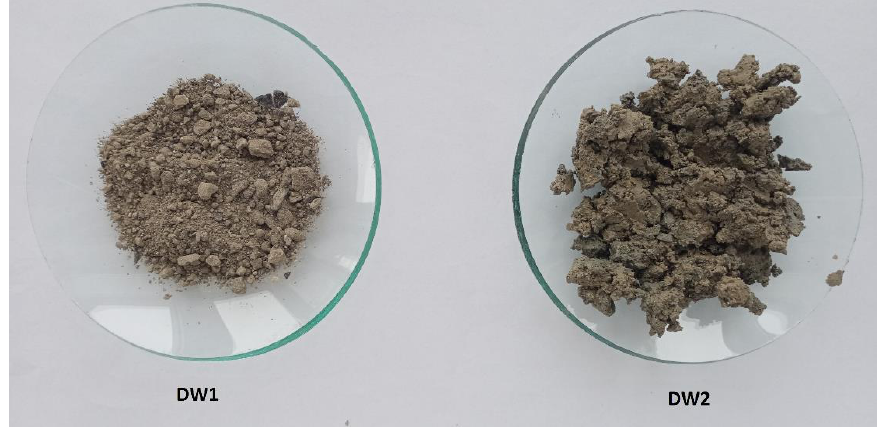
Figure 1. Photographs presenting drilling waste DW1 (code 01 05 06*) and DW2 (code 01 05 08) (photo: M. Gajec).